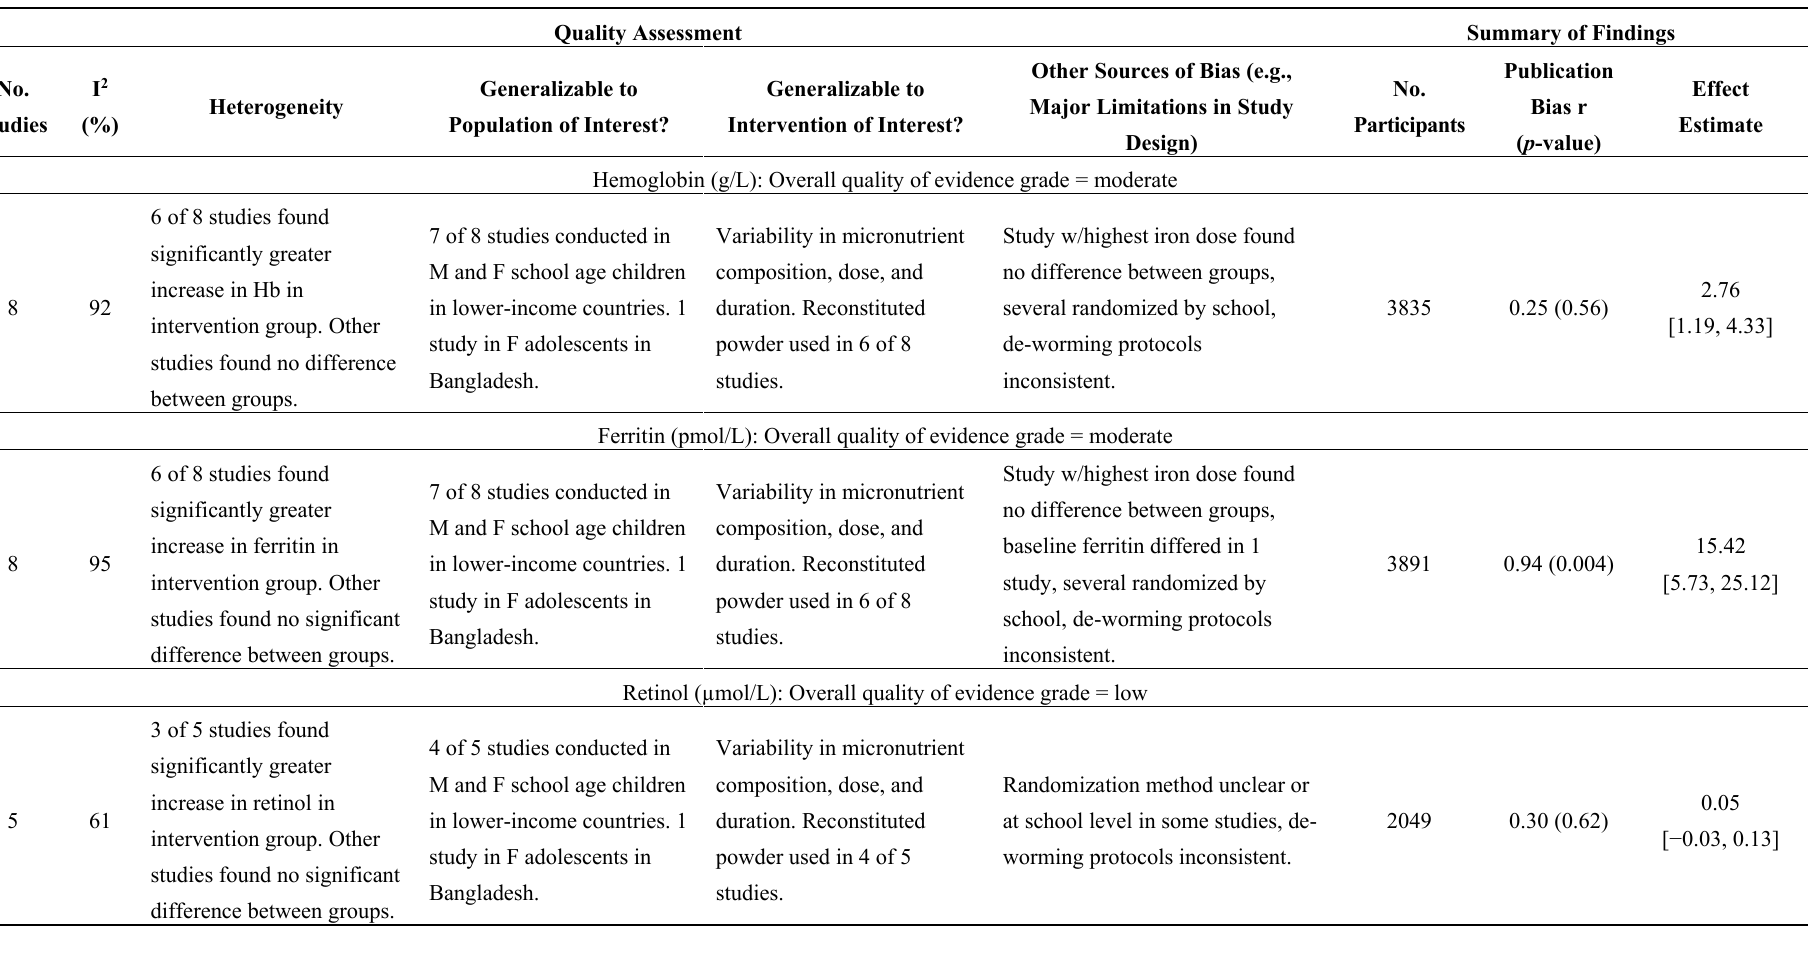
Table 4. Summary of findings and overall assessment of quality of evidence grade by study